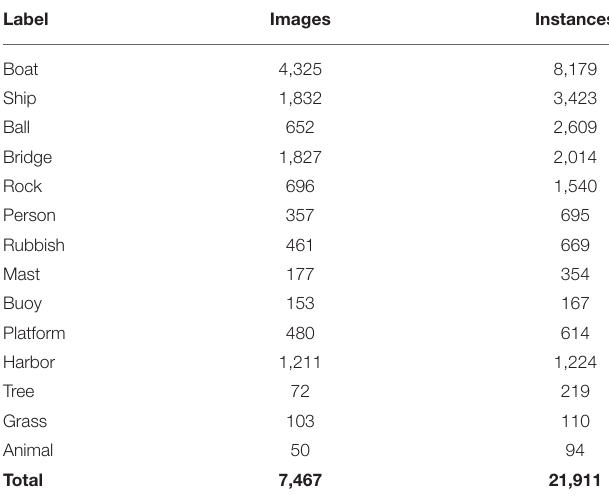
TABLE 2 | Images and instances for each